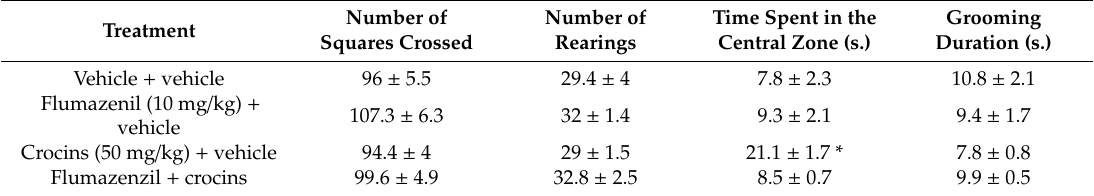
Table 1. E ff ects of acute treatment with crocins and flumazenil on rats’ performance in the open field test (n = 8 rats per